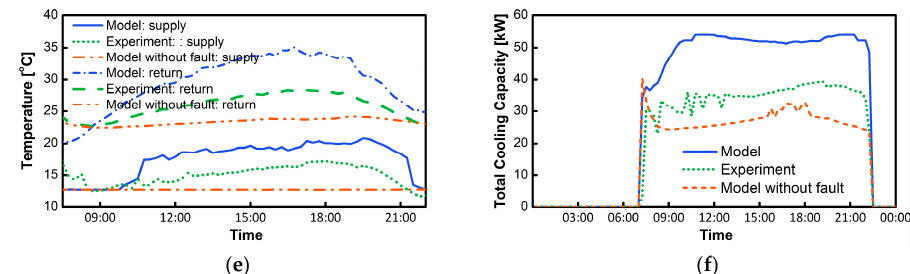
Figure 15. Total building electricity consumptions of baseline and faulted scenarios: Excessive infiltration through the building envelope. ( a ) baseline: return/supply temperatures; ( b ) baseline: total cooling capacity; ( c ) damper 50% open: return/supply temperatures; ( d ) damper 50% open: total cooling capacity;